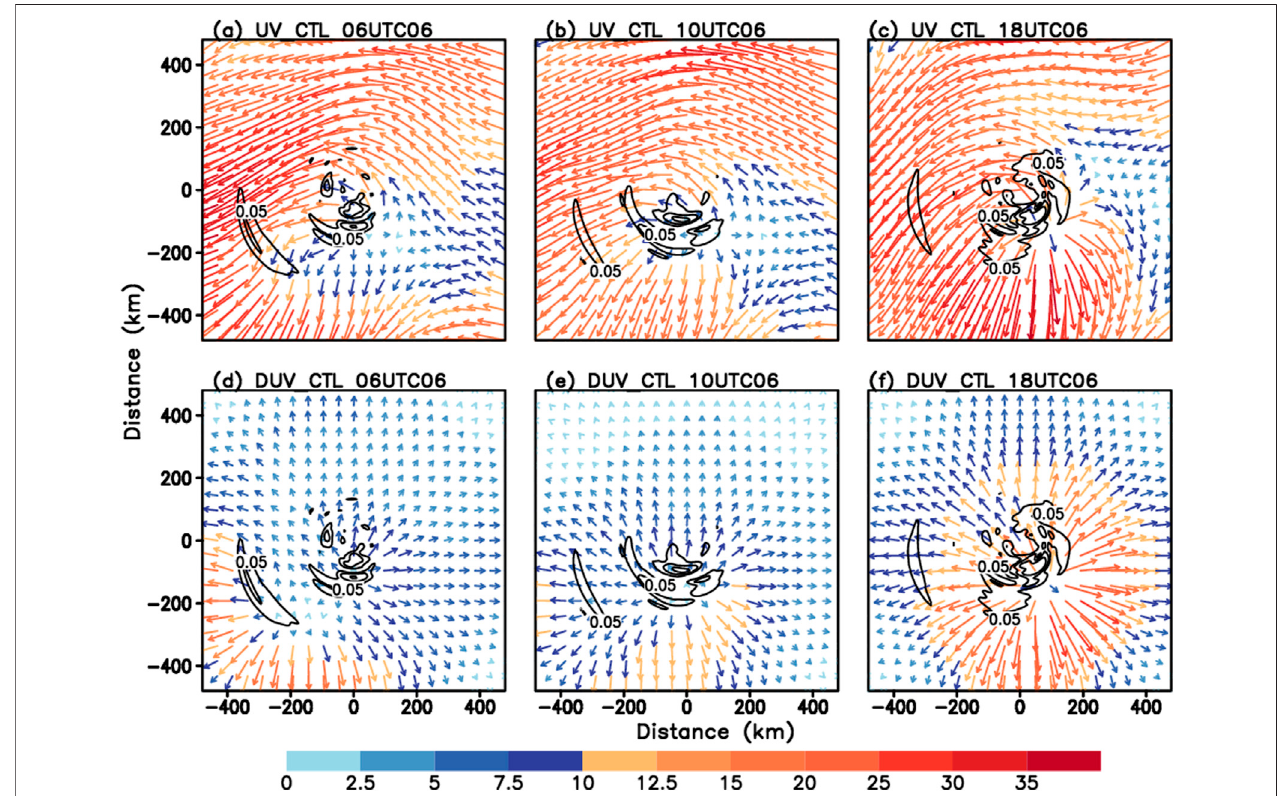
FIGURE8| Upperpanels:thetimeevolutionofthewindcirculation(vector,units:m s − 1 )andthediabaticheating(blackcontour,units:K/h)at15-kmheightinCTL. Lower panels: the time evolution of the divergent wind (vector, units: m s − 1 ) and the diabatic heating (black contour, units: K/h) at 15-km height in CTL.